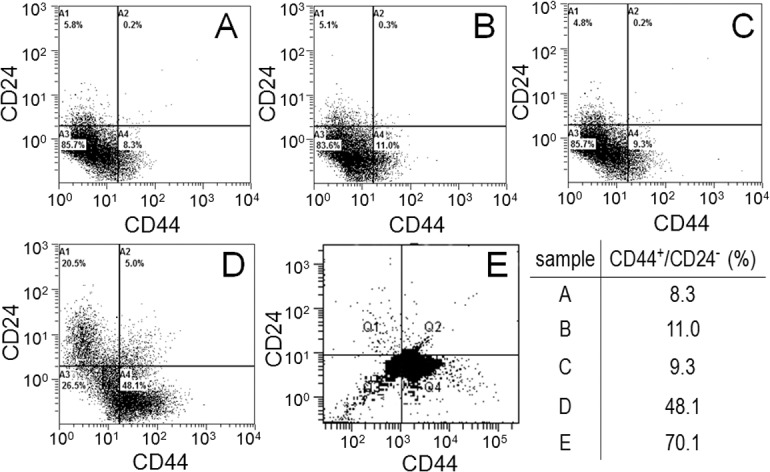
CSC fraction of MDA231 cells encapsulated in the patterned 5 kPa gel.MDA231 cells cultured on adherent tissue culture plate (TCP, A), non-adherent tissue culture plate (suspension, B), by encapsulation in Matrigel (C), encapsulation in un-patterned 5 kPa PEGDA gel (D), and encapsulation in 50 μm patterned 5 kPa PEGDA gel; (F) CSC fraction of the MDA231 cells in (A-E) as the sub-population of cells in the fourth quadrant (CD44+/CD24-).